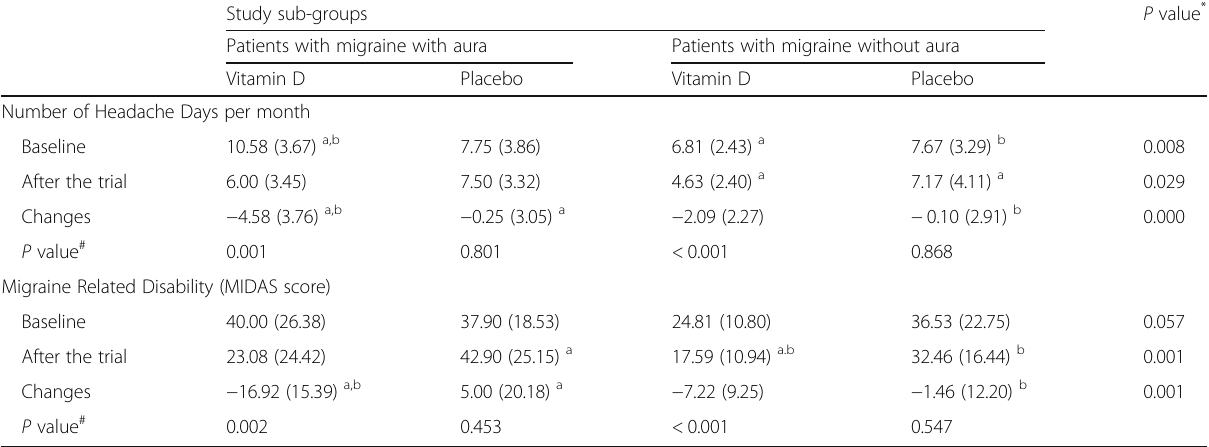
Table 3 Changes in number of headache days, and migraine disability scores before and after supplementation with vitamin D or placebo in episodic migraine patients with/without aura